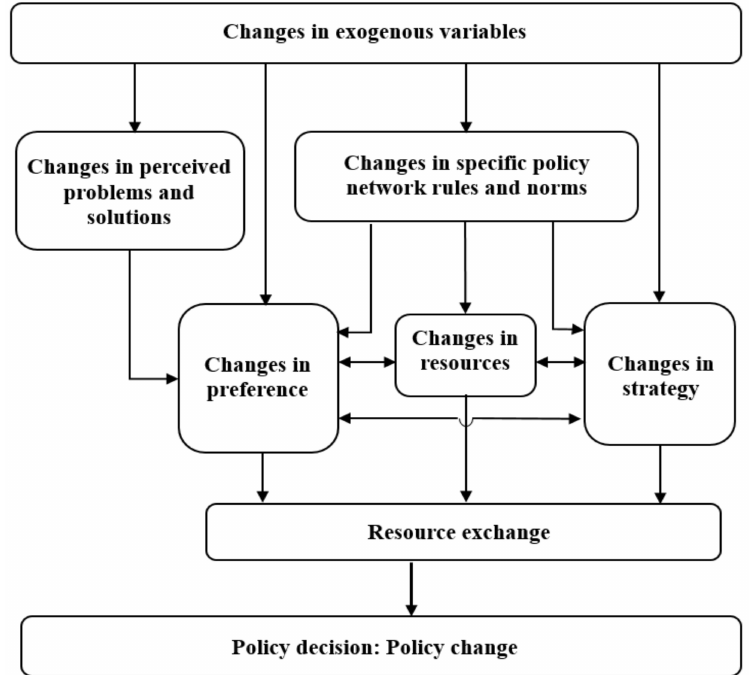
Figure 2. Policy network model explaining policy change (Source: Adapted from reference